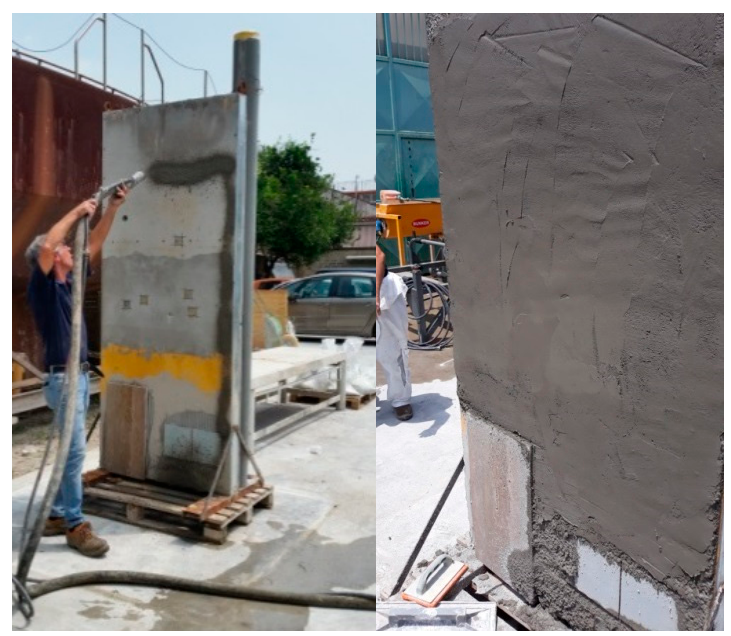
Figure 5. Left: Plaster pouring on a vertical panel. Right: results after pouring.